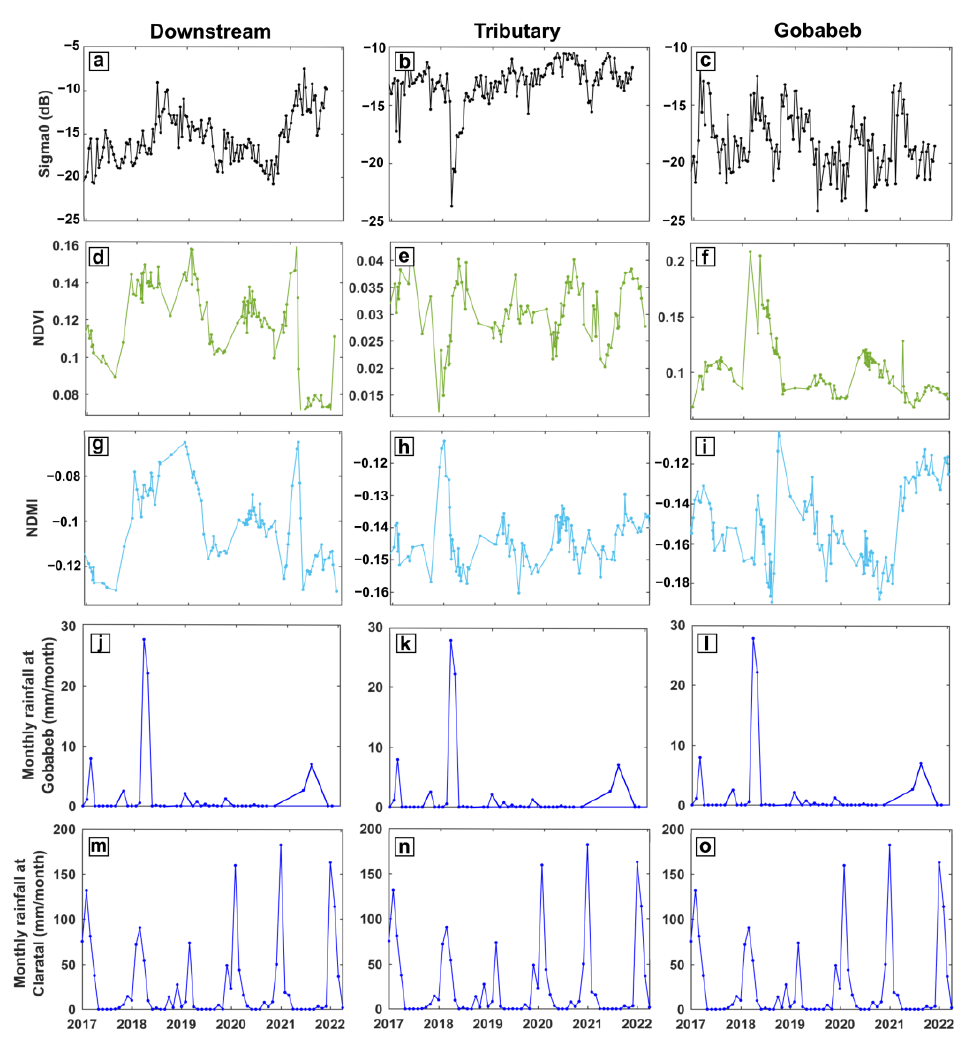
Figure 5. ( a ) Time-series of σ o (in VV polarization, in dB) at Gobabeb, ( b ) in the Klipneus tributary and ( c ) in the delta downstream. ( d ) Time-series of NDVI spectral index at Gobabeb, ( e ) in the Klipneus tributary and ( f ) in the delta downstream. ( g ) NDMI spectral index at Gobabeb, ( h ) in the Klipneus tributary and ( i ) in the delta downstream. ( j – l ) are time-series of rainfall (mm) at Gobabeb and ( m – o ) are time-series of rainfall (mm) at Claratal in the upper catchment of the Kuiseb River.